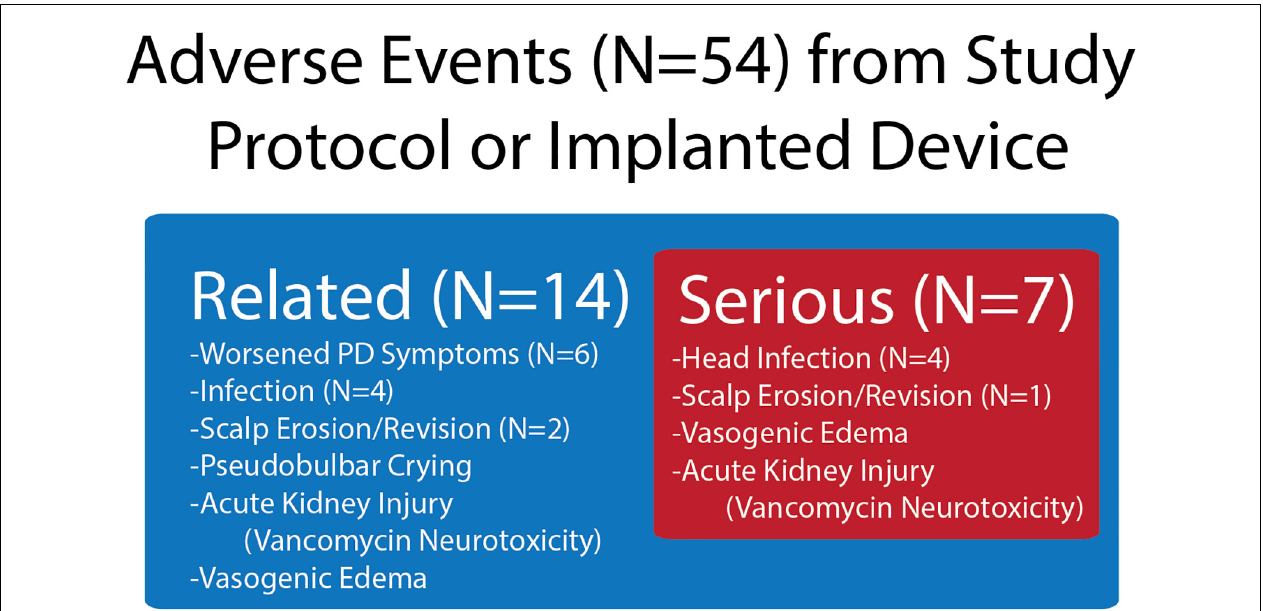
FIGURE 2 | Device- and procedure-related adverse events (AEs) in the study, which were drawn from all AEs. Shown in the figure are the number of AEs related to the device or study protocol and from the related number of those AEs that were severe.